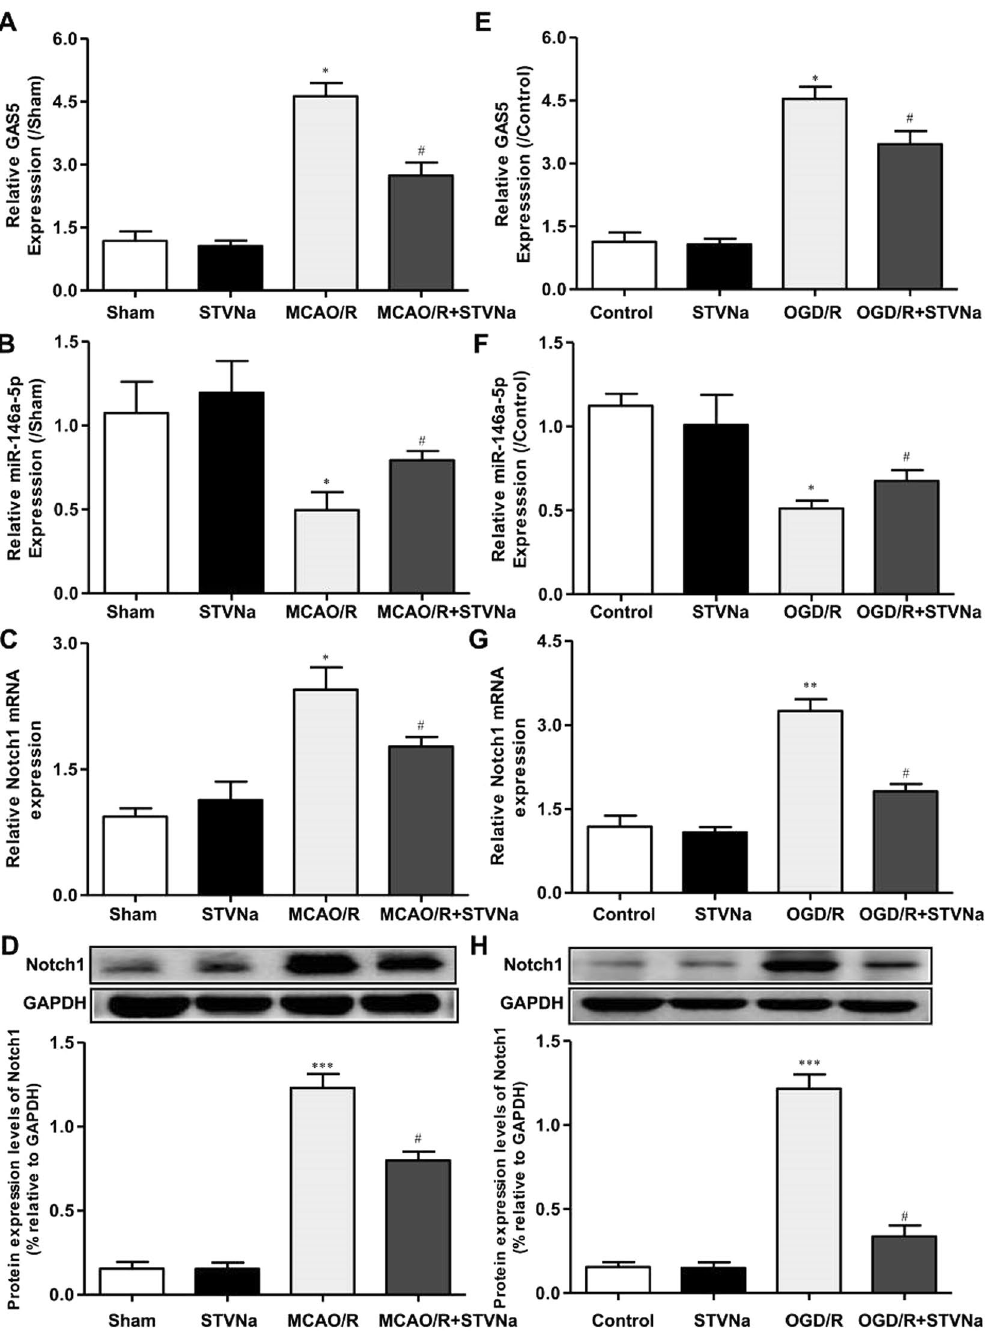
Figure 10. STV-Na disrupted the GAS5/miR-146a-5p to inhibit Notch1 expression after stroke in vivo and in vitro . RT-PCR assay for the expression of GAS5 ( A ), miR-146a-5p ( B ) and Notch1 ( C ) in mice subjected to MCAO/R (n = 3 per group). RT-PCR was used to detect the expression of GAS5 ( E ), miR-146a-5p ( F ) and Notch1 ( G ) in BV2 microglial cells subjected to OGD/R (n = 3 per group). ( D , H ) Western blotting analysis of Notch1 in the ischemic cortex after MCAO/R. ( H , J ) Western blotting analysis of Notch1 in BV2 microglia cells after OGD/R. Data are represented as mean ± SD, * P < 0.05, versus Sham or Control; # P < 0.05, ## P < 0.01, versus MCAO/R or OGD/R